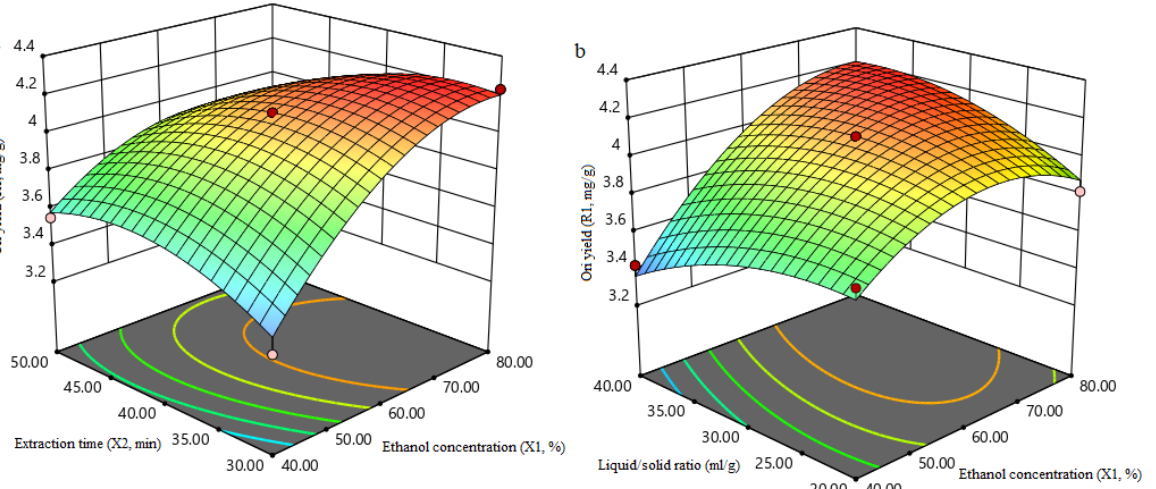
Figure 2. 3D response surface plots of independent variables in extraction yield of Ori: ( a ) Effects of ethanol concentration and extraction time on the yield of Ori; ( b ) Effects of ethanol concentration and Liquid/solid ratio on the yield of Ori; ( c ) Effects of etraction time and Liquid/solid ratio on the yield of Ori. 3.1.4. Verification of Predictive Model By using the Design Expert 12.0 software, the optimal conditions for the extraction of Ori were obtained and recognized as ethanol concentration ( X 1 ) of 75.9%, extraction time ( X 2 ) of 35.7 min, and liquid/solid ratio ( X 3 ) of 32.6 mL/g. The predicted Y value, under these optimal conditions, was 4.28 mg/g. The experimental value was 4.23 ± 0.26 mg/g ( n = 3) under the above modified conditions. No significant differences were found between the predicted and experimental results on Ori yield ( p > 0.05). The result